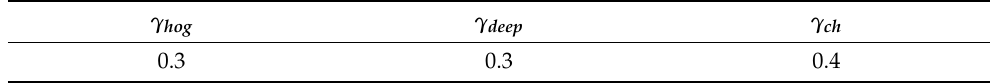
Table 1. Multi-feature fusion hyperparameter